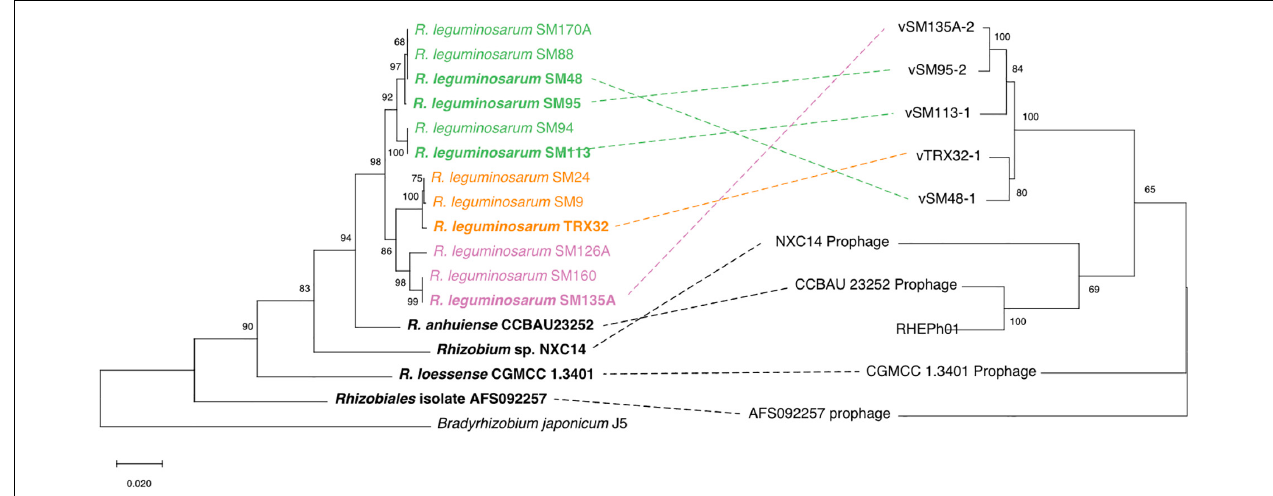
FIGURE 5 | The phylogenies vTRX32-1-like phages and their bacterial hosts. The phage phylogeny (right) was produced using the concatenated nucleotide sequence of 5 conserved genes (see section “Materials and Methods”). The bacterial phylogeny (left) is based on the nucleotide sequence of the housekeeping gene recA . The colored highlights group Rhizobium leguminosarum strains into their respective genospecies. Lysogenic strains are shown in bold and dotted lines link prophage to their bacterial hosts. Branch lengths indicate substitutions per site for both phylogenies (scale shown in bottom left). Numbers by each clade indicate the percent of bootstrap replicates that support each clade.